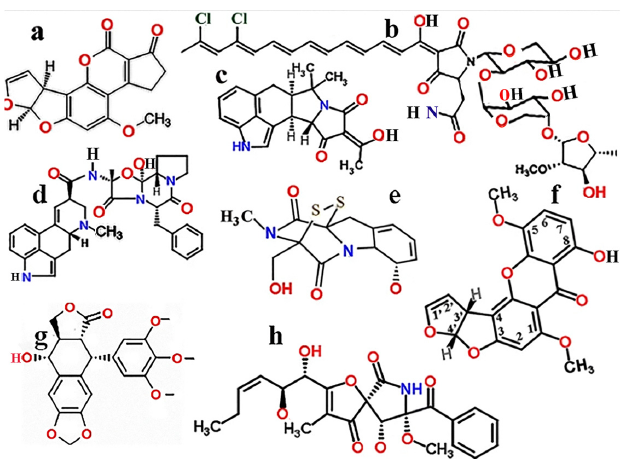
Figure 1. Major carcinogenic Aspergillus mycotoxins. Polyaromatic: aflatoxin ( a ), aliphatic com- pounds: aurantosides ( b ), cyclopiezonic acid ( c ), ergotamine ( d ), podophyllotoxin ( e ), gliotoxin ( f ), stigmatocystins ( g ), pseurotin ( h ). Modified with permission [32].